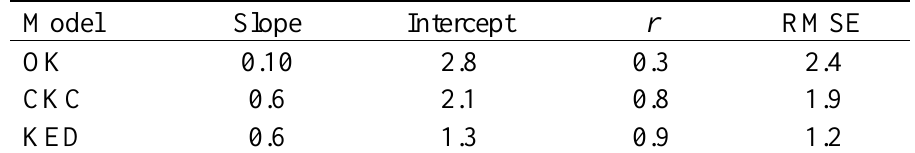
Table 3. Statistics derived between the OK, CKC and KED LAI fields and the high-resolution LAI reference map at a significance level of 95%.